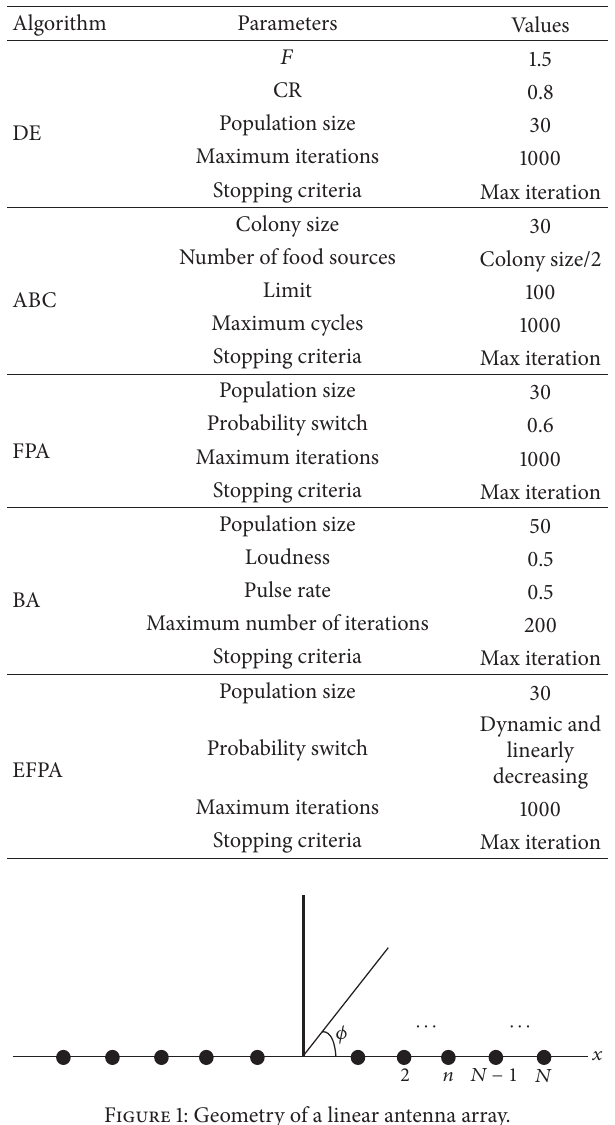
Table 2: Parameter settings of various algorithms. Algorithm